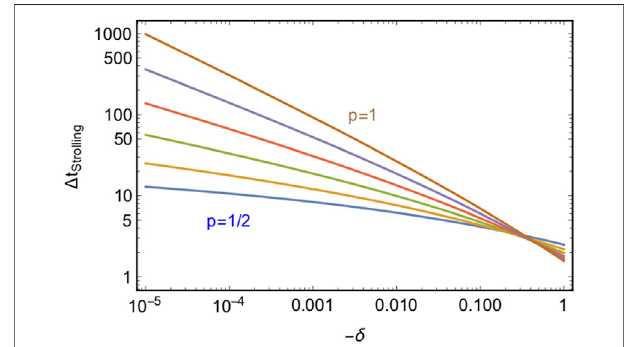
FIGURE 2 | Values of Δ t Strolling for p (cid:2) 0.5 – 0.9 and